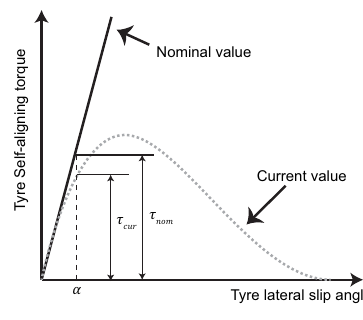
Figure 20. Lateral grip margin concept described in Yasui et al. [38]. Figure adapted by the authors from